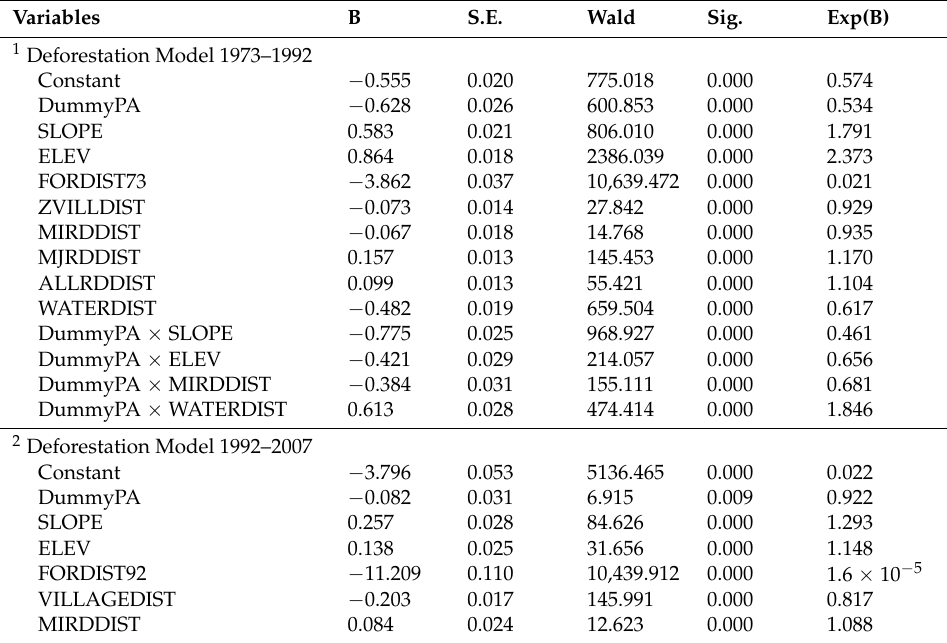
Table 3. Logistic regression parameters estimated from